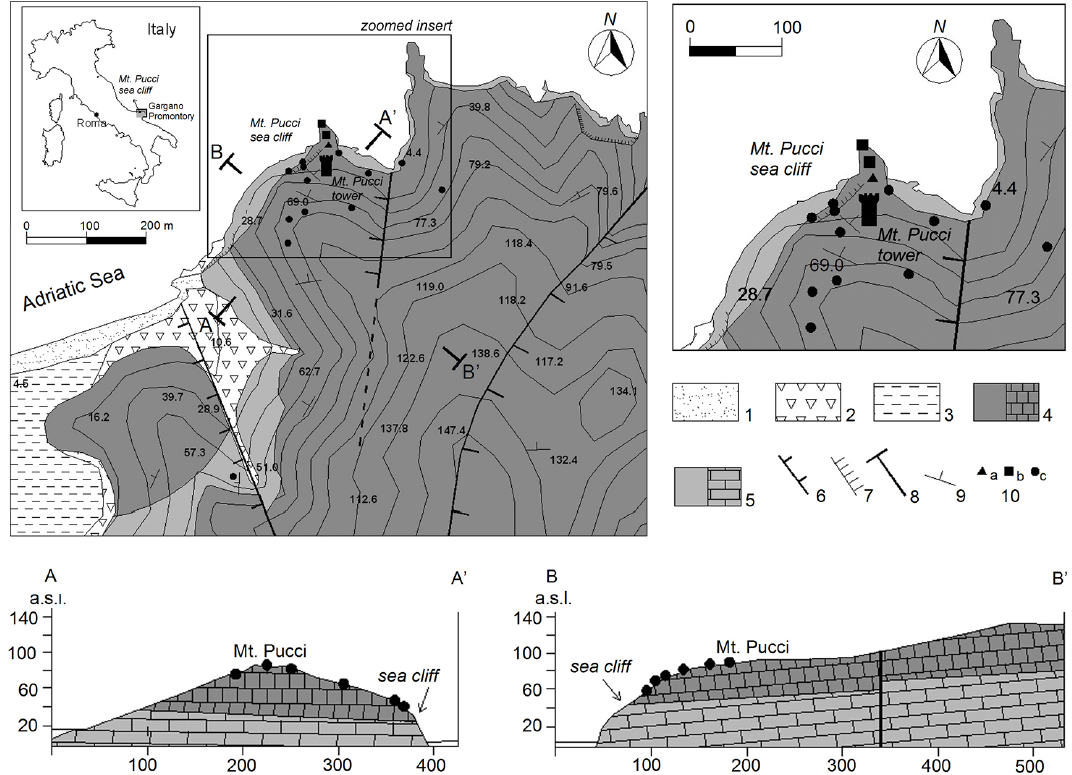
Fig. 2. Geological sketch of the Mt. Pucci coastal area: (1) coastal deposits; (2) slope debris; (3) alluvia; (4) calcarenites of the Peschici Fm. (PSH), Eocene; (5) marly limestones of the Scaglia Fm. (SC), lower–middle Cretaceous; (6) certain fault; (7) cliff scarp; (8) trace of geological section; (9) attitude of beds; (10) measurement points: (a) GBInSAR, (b) TLS and IRT, (c) geomechanical scanlines.